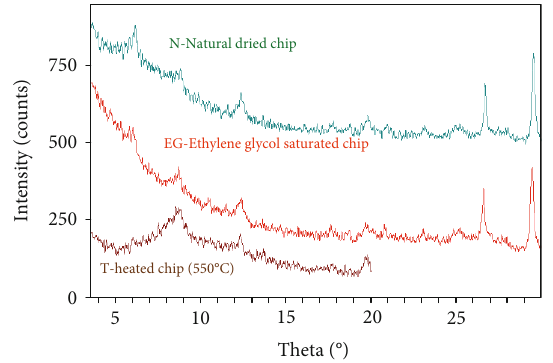
Figure 4: XRD analysis results of the representative soil